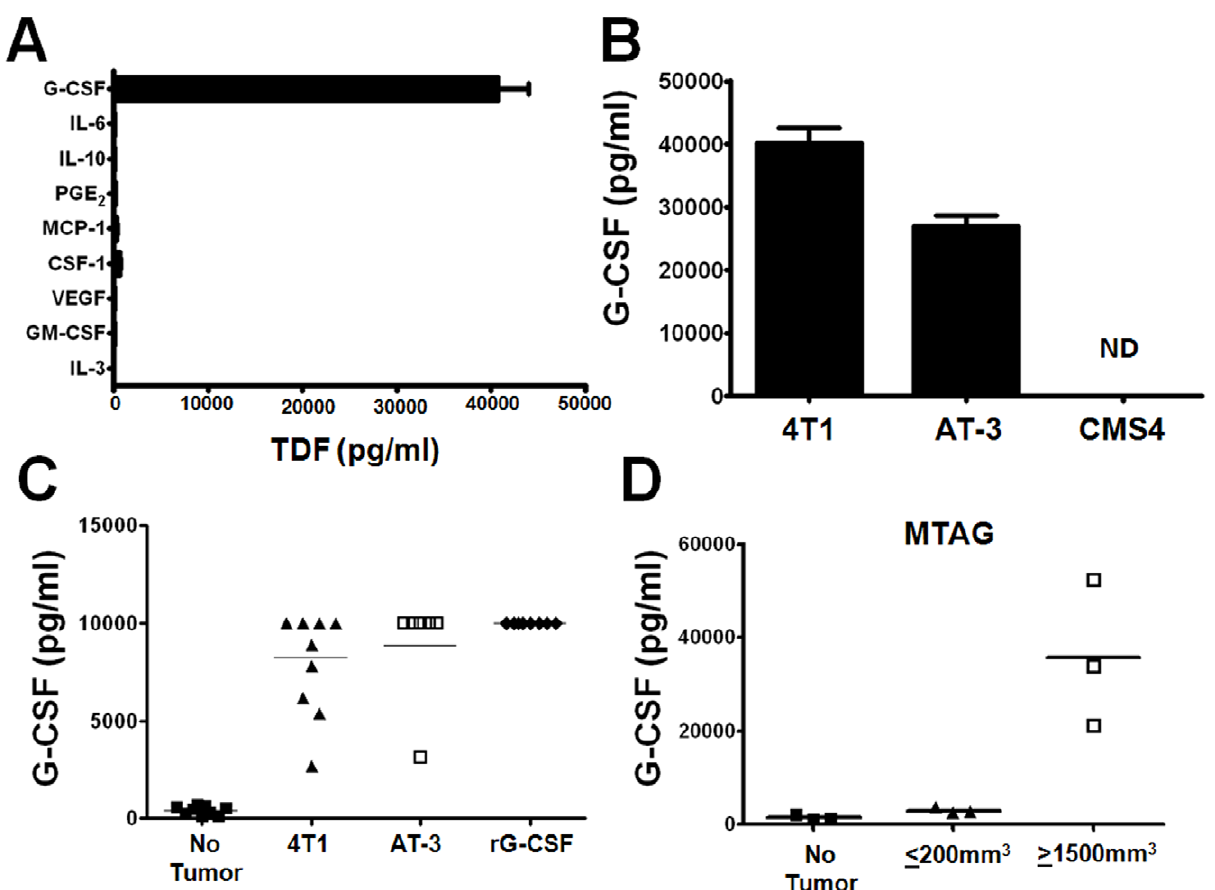
Figure 1. G-CSF production by various mouse tumor models. ( A ) Cell-free supernatants from 4T1 tumor cells were analyzed for the indicated TDF by ELISA. Data are reported as pg/ml/10 6 cells/24 hr, and reflect the mean 6 SEM of 3 or more separate experiments for each cytokine tested. ( B ) G-CSF levels were then analyzed in a similar fashion for the AT-3 and CMS4 tumor cell lines. Data are reported as the mean 6 SEM of triplicate determinations, and are representative of 3 separate experiments. ( C ) Sera G-CSF levels determined from nontumor-bearing mice (n=10), mice treated with recombinant G-CSF protein (10 m g daily for 5 consecutive days) (n=8) or mice bearing 4T1 cells (n=9) or AT-3 tumor cells pooled from two separate experiments (n=9; overall tumor volume # 2cm 3 ). Each data point represents the results from an individual mouse. G-CSF levels of all experimental groups were significantly different compared to the nontumor-bearing control mice ( P , 0.0001). ( D ) Sera were collected from MTAG mice at the tumor burdens indicated, and analyzed for G-CSF levels. Mice bearing small tumor burdens showed significantly elevated ( P , 0.04) levels of G-CSF compared to MTAG mice without measurable tumor growth. G-CSF levels were more pronounced at larger tumor burdens ( P , 0.02, compared to ‘no tumor’ group). Each data point represents a single